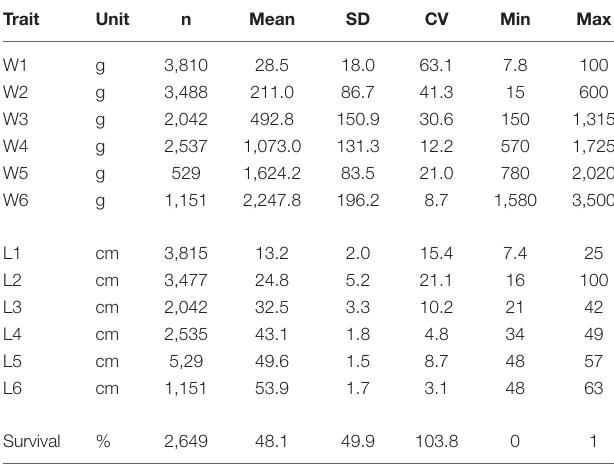
TABLE 1 | Number of observations (n), mean, standard deviation (SD), coefficient of variation (CV, %), minimum, and maximum values for body weight and length during the growth trajectory.